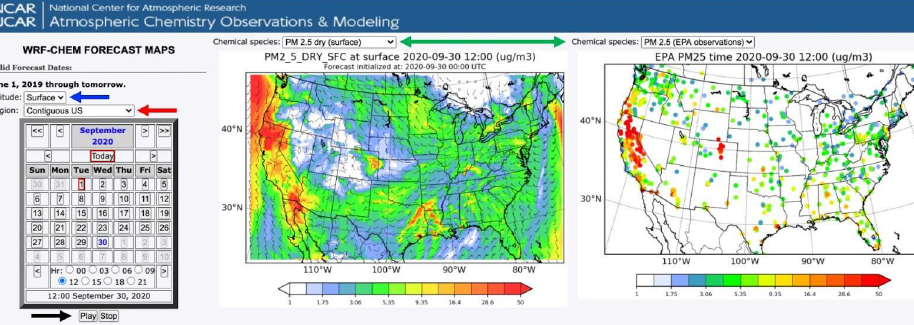
Figure 2. A snapshot of the information dissemination system. Green, blue, and red arrows point to the drop-down menus where the users can select the chemical species, altitude, and region of their choice. Black arrow points to the button to play/stop animation of the forecast. Figure based on [29].